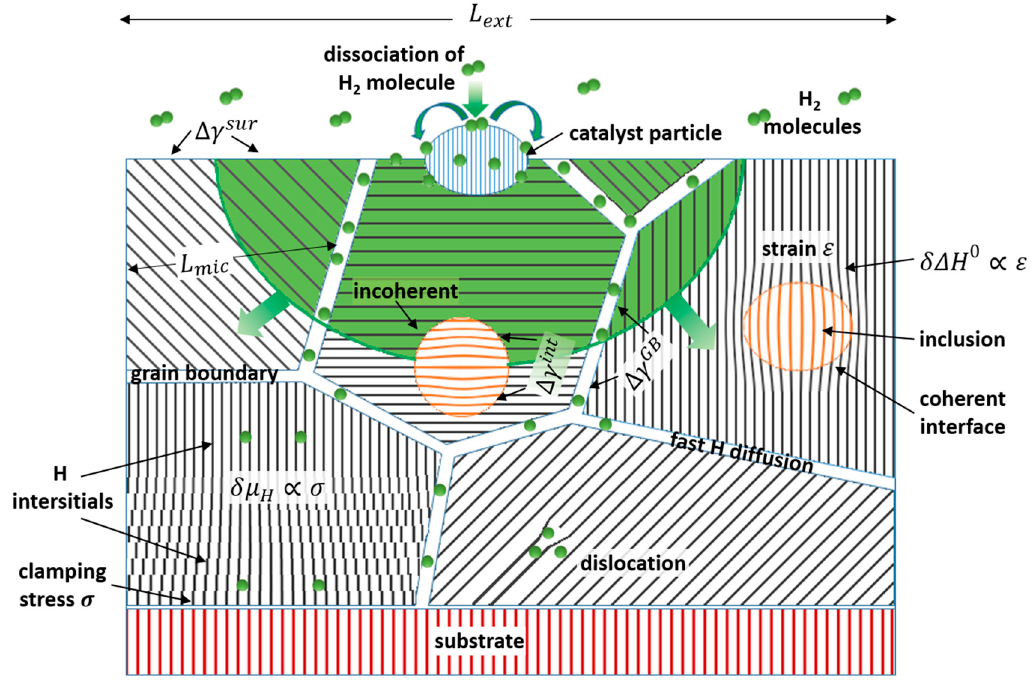
Figure 3. Structural and geometrical features relevant to H sorption in nanomaterials. L ext represents the overall spatial extension of the system, as delimited by either its surface or a supporting substrate. L mic is the characteristic length scale of the microstructure, e.g., its grain size. The growth of the hydride phase, depicted in green, requires H 2 dissociation possibly favored by a catalyst, subsurface penetration, and H diffusion, which is accelerated along internal interfaces or line defects (dislocations). Stress ( σ ) and strain ( ε ) fields associated with inclusions or substrate interaction modify the chemical potential µ H of H or the enthalpy of hydride formation ∆ H 0 . The specific free energy of interfaces, grain boundaries (GBs) and surfaces undergoes a change ∆ γ upon H absorption that leads to a thermodynamical bias. The coherent vs. incoherent nature of the interfaces determines whether long-range strain fields or localized excess free energy bring a relevant contribution to the energetics of the phase transformation.